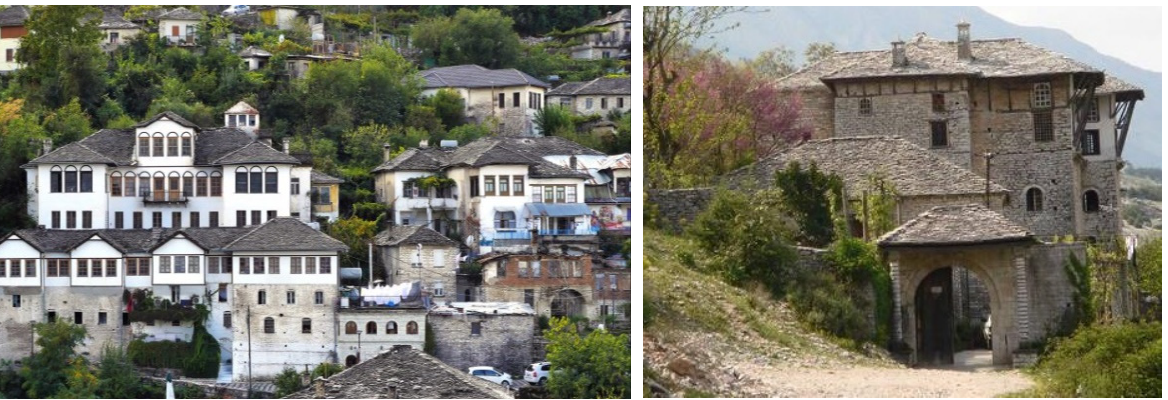
Figure 1. Location of the city ( left ) and aerial view of the old city center ( right ).